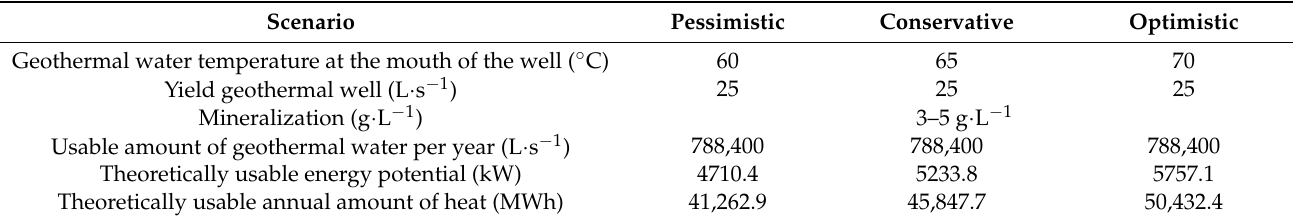
Table 1. Predicted parameters of the proposed geothermal